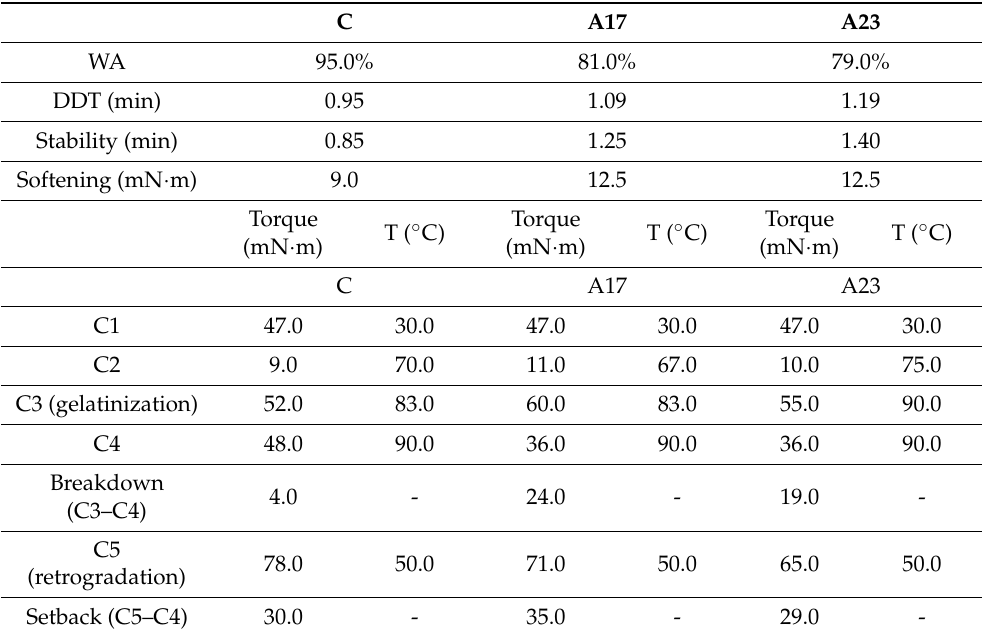
Table 3. Torque values (mN · m) and respective temperatures ( ◦ C) along pasting curves for GF flour blends: (C) control, without apple flour, (A17) with 17%, and (A23) with 23% apple flour addition. C A17 A23 WA 95.0% 81.0% 79.0% DDT (min) 0.95 1.09 1.19 Stability (min) 0.85 1.25 1.40 Softening (mN · m) 9.0 12.5 12.5 Torque Torque Torque T ( ◦ T ( ◦ C) T ( ◦ C) (mN · m) (mN · m) (mN · m)